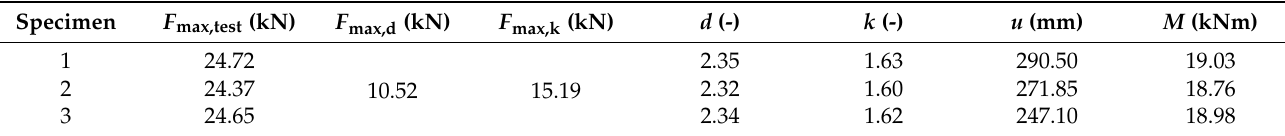
Table 7. Results of Experiment B, fully threaded screws; see Johanides 2022